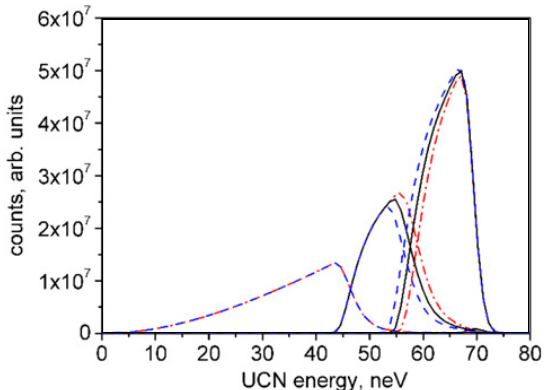
Figure 8. Simulated UCN spectra after a short holding time for the same measurements as shown in Fig. 7, i.e., at different tilt angles of the trap: 14 ◦ (dash-dotted red line), 15 ◦ (solid black line), 16 ◦ (dashed blue